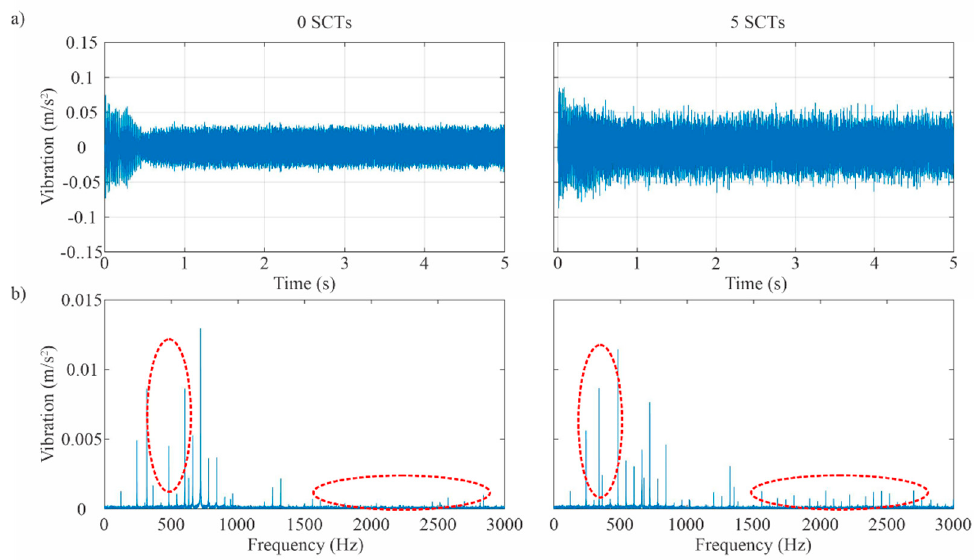
Figure 5. Vibration signals in ( a ) time domain and ( b ) frequency domain.